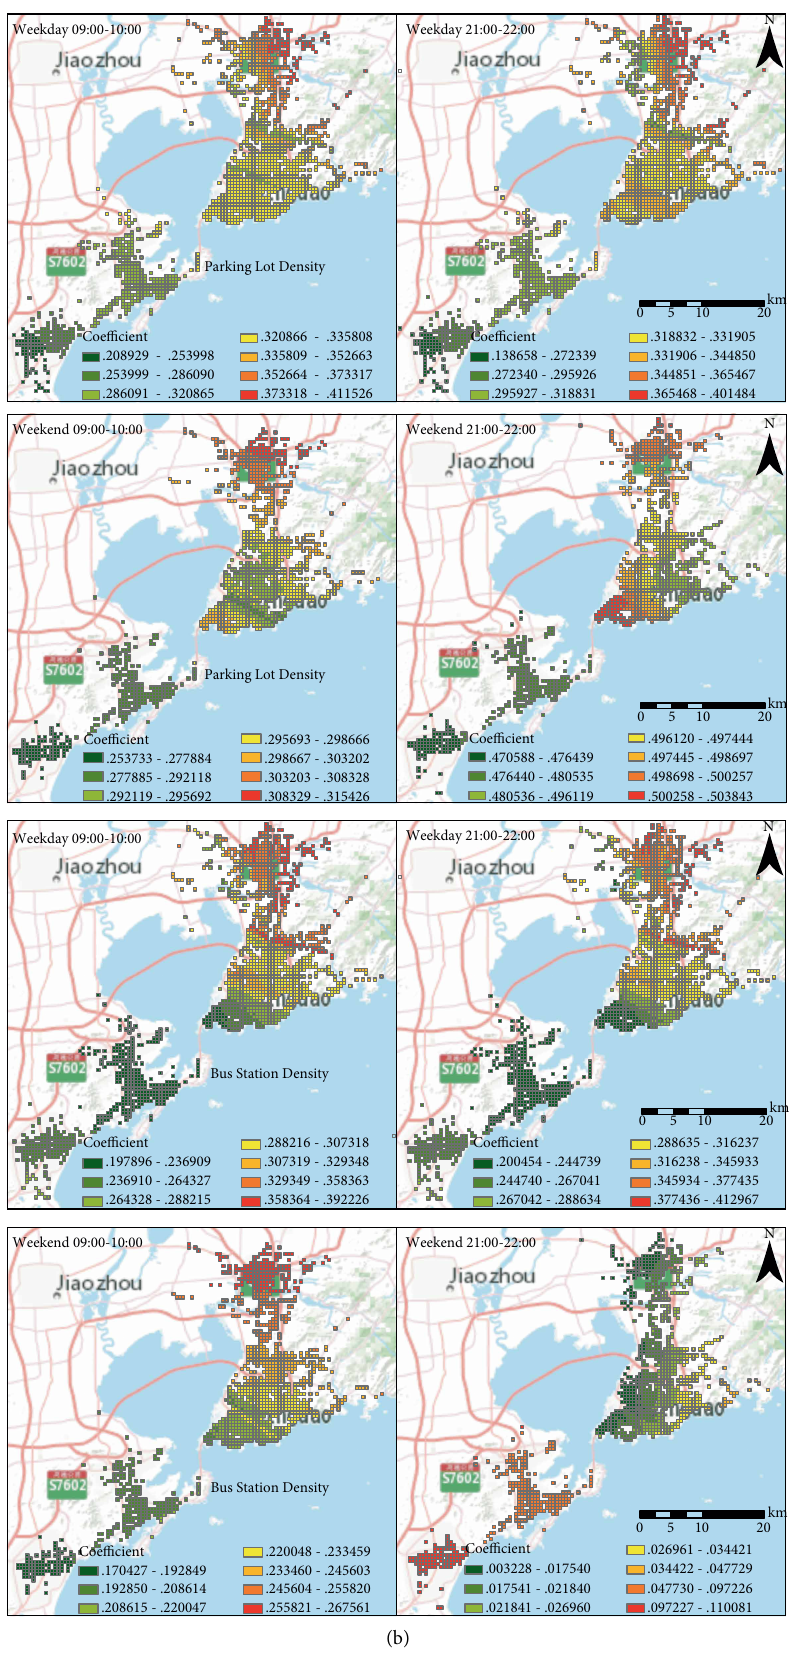
Figure 9: Spatial distribution for the coefficients of transport factors for weekday and